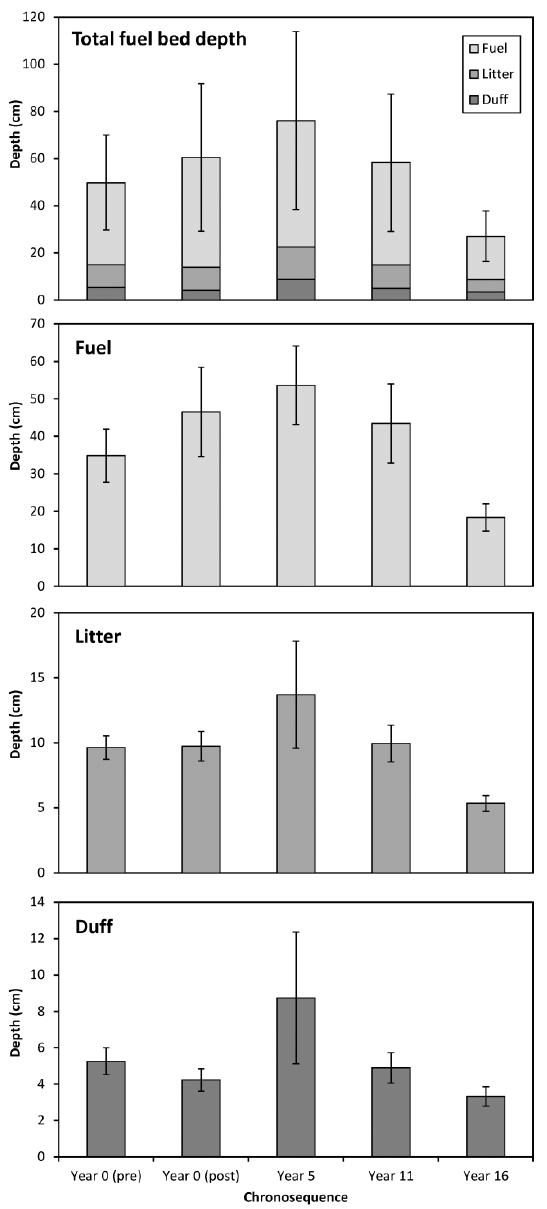
Figure 4. Average fuel bed depth for duff, litter and woody fuels combined, and separately, showing means and standard errors for each stage in chronosequence: pre-treatment and post-treatment year 0 (partial harvest and frill treatment) at Lupton Creek, and year 5, 11, and 16 after frill treatment rehabilitation treatments (no harvest) at Little Pine Creek.